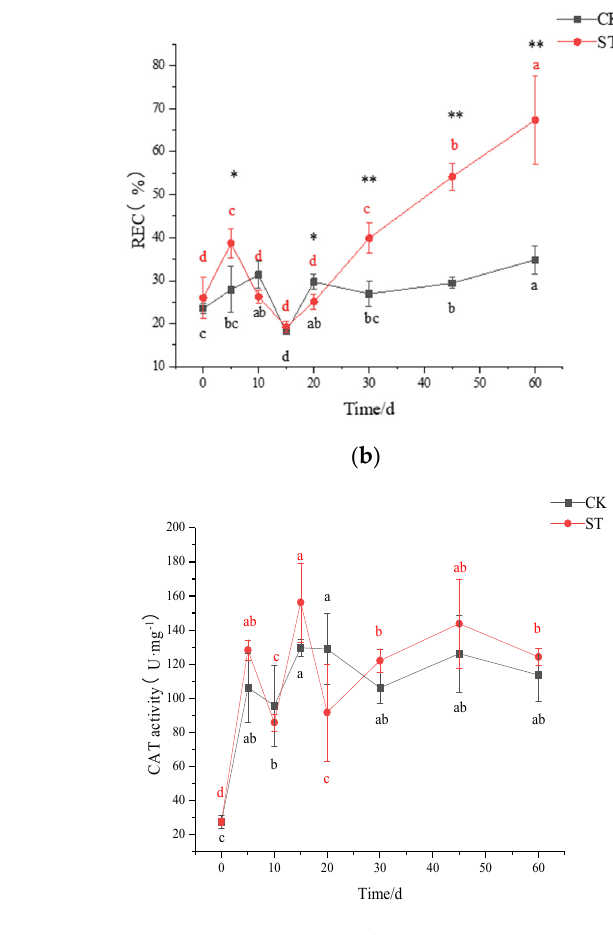
Figure 3. Changes in ROS accumulation in leaves of C. hongkongensis subsp. tonkinensis under salt stress.